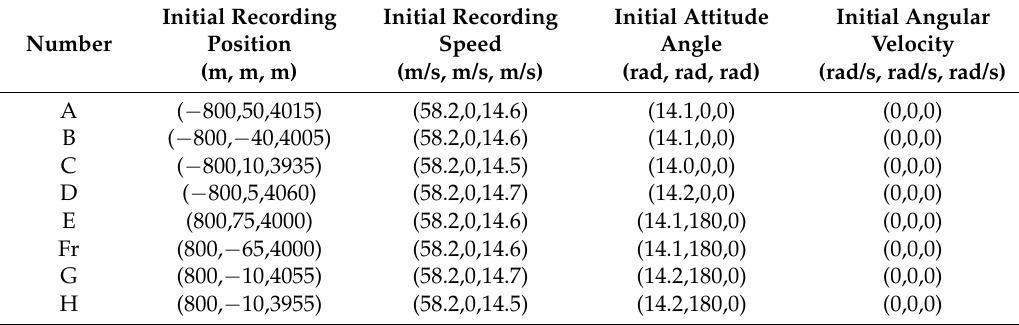
Table 10. Initial Table 10. Initial state.